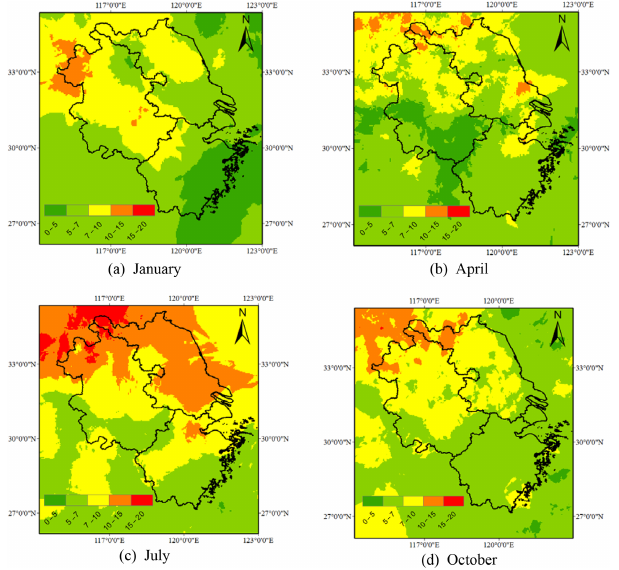
Figure 3. The spatial distribution of monthly average of NH 3 ver- tical columns over the YRD region from IASI satellite observation (10 15 molec.cm − 2 ).